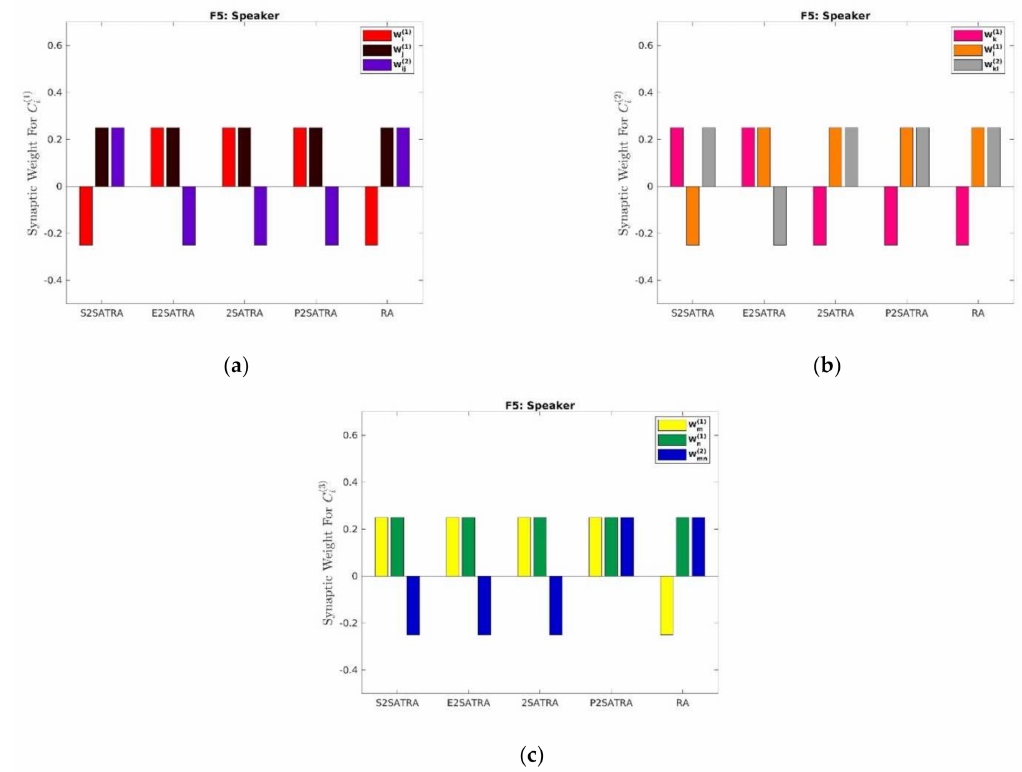
( 1 ) ( 2 ) ; ( b ) C and ( c ) C i i